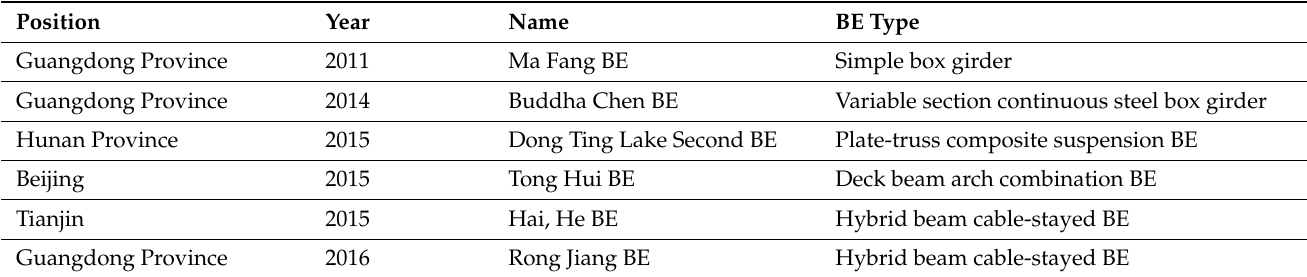
Table 4. Applications of UHPCs in BE deck pavement in China.